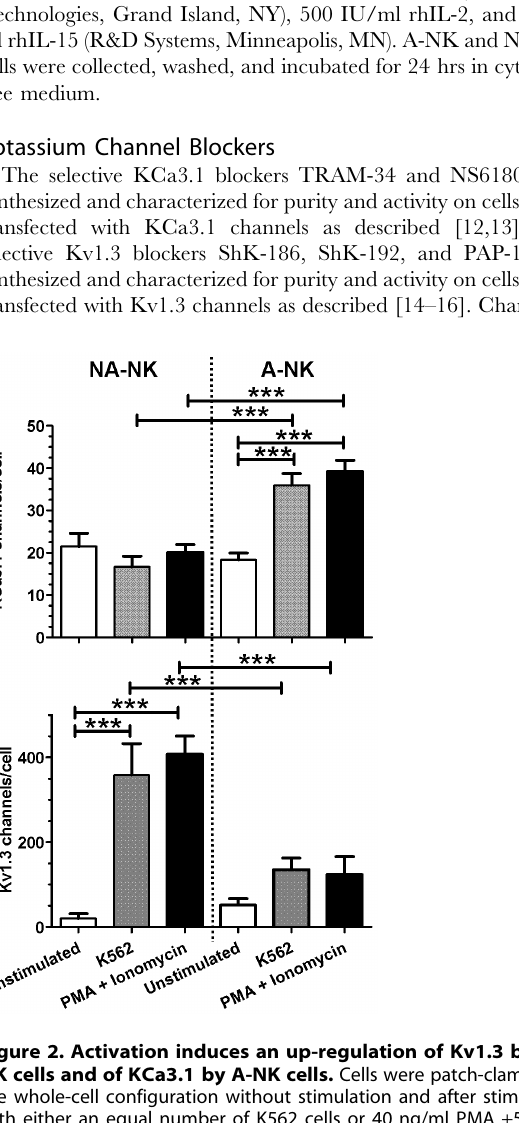
non-essential amino acids, 1% vitamins, and 5% FBS (all from Life